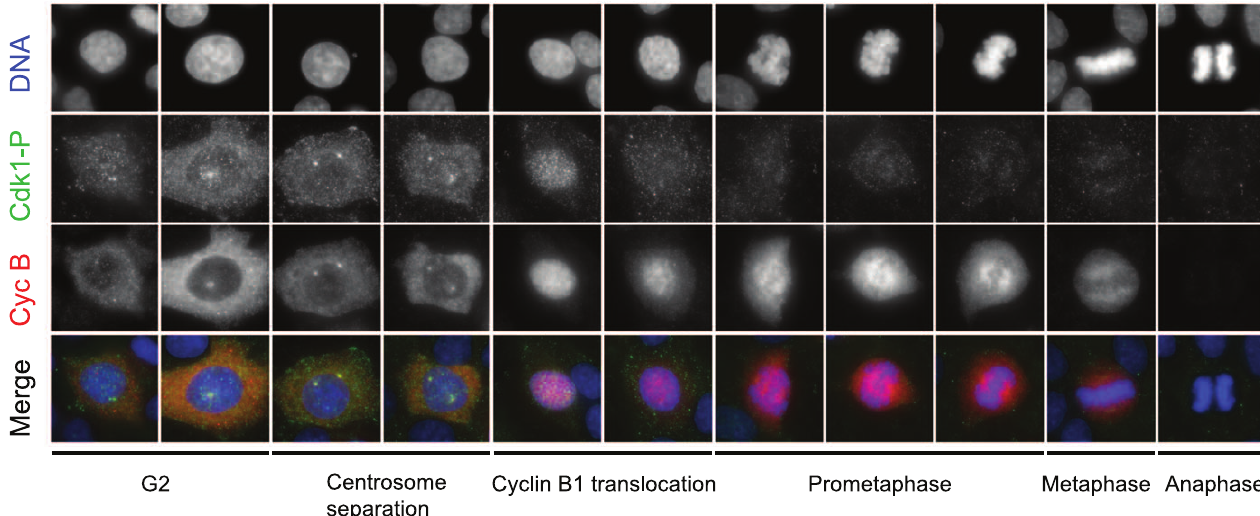
Figure 1. Immunofluorescence Pattern of Cyclin B1 and Y15 Phosphorylated Cdk1 from Early G2 Phase to Anaphase in HeLa Cells Fluorescence images are undeconvolved maximum intensity projections of unsynchronized cells from a single cover slip. Cells are presented from G2 (left) to anaphase (right). Top row: DNA, second row: phosphorylated Cdk1, third row: cyclin B1, bottom row: merge of all three fluorescence channels.